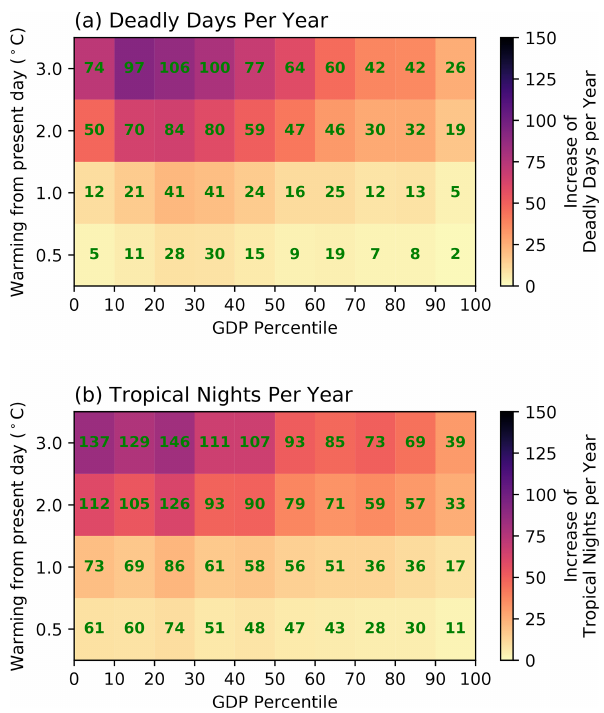
Figure 8. Increase in (a) deadly days and (b) tropical nights com- pared to the reference period (0.87 ◦ C of warming), binned by the percentile of GDP per capita at selected levels of warming com- pared to reference climate (calculated by subtracting reference val- ues, shown as a heat map), averaged over the population within the GDP percentile (for example, averaged over population in 0– 10 percentile of GDP) and over all ensemble members for 5-year window after each level of warming first occurs. Green text inside the heat map represents the absolute number of deadly days and tropical nights in each level of